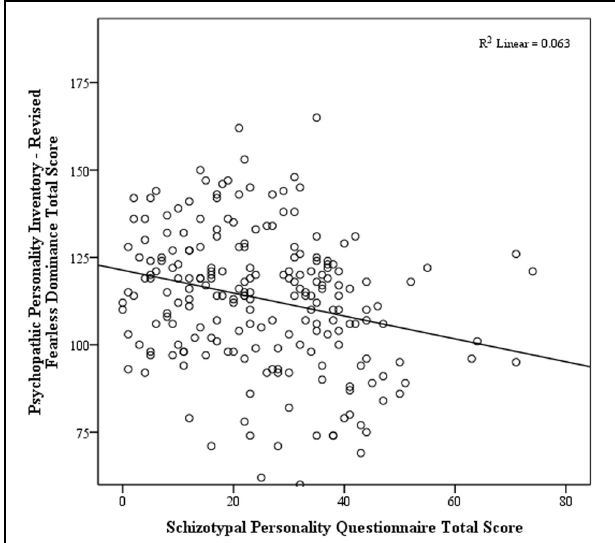
FIGURE 2 | Scatterplot of total schizotypy and fearless